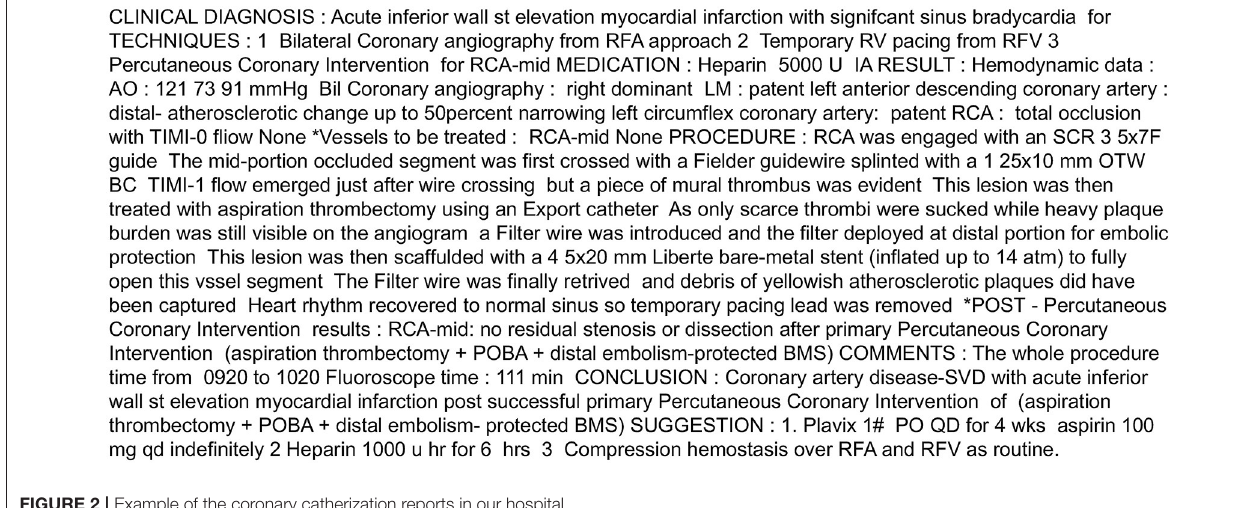
FIGURE 2 | Example of the coronary catherization reports in our hospital.